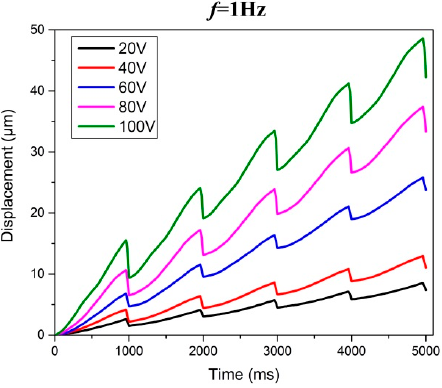
Figure 9. Motion displacement under different input voltages.